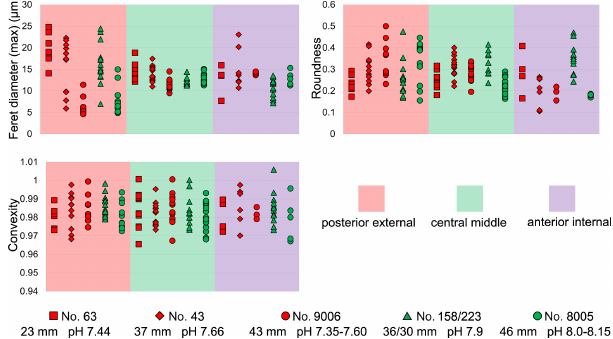
Figure 8. Comparisons of the fibre size and shape of M. venosa (ventral and dorsal valves) at different positions along the posterior– anterior axis; pH conditions of culturing or natural environment are reported. One circle point represents one measurement. Out- liers have been removed, identified with Tukey’s fences (Tukey, 1977) when falling outside fences F1 and F2 (F1 = Q1 − 1.5IQR; F2 = Q3 + 1.5IQR; Q1/Q3: first/third quartiles; IQR (interquartile range):